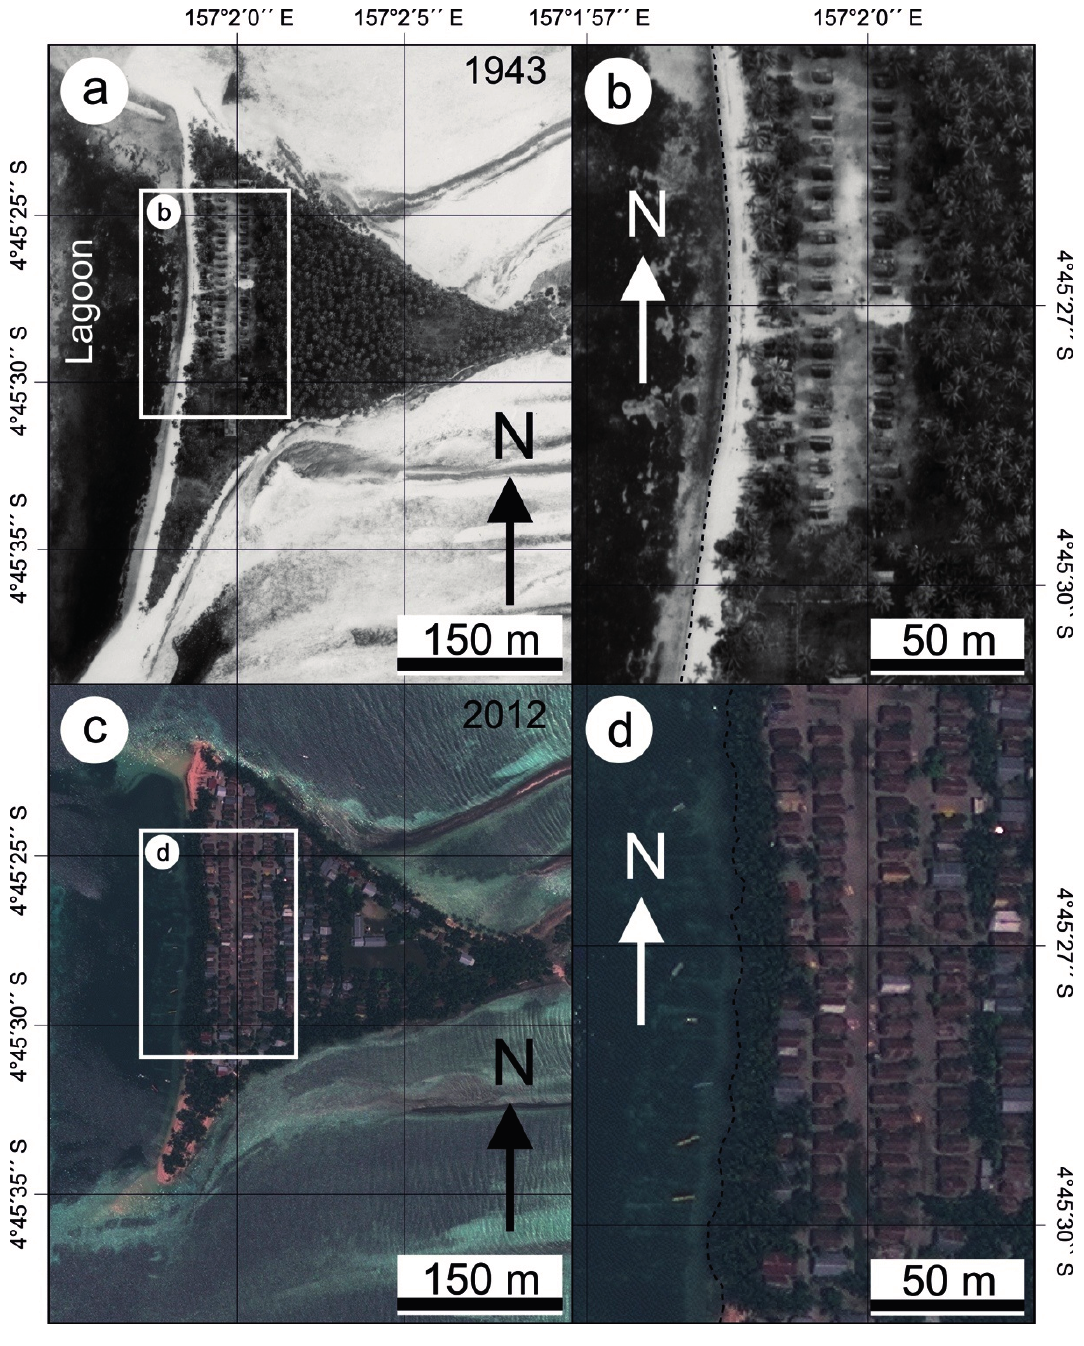
Figure 8. Nukutoa Island in 1943 ( a , b ) and 2012 ( c , d ). The island has developed considerably since 1943 and is densely populated now. The lagoonward beaches virtually disappeared over the study period (cp. b and d). Aerial photograph (a) was provided by the Bernice Pauahi Bishop Museum (www.bishopmuseum.org), satellite image (c) is © DigitalGlobe, supplied by European Space